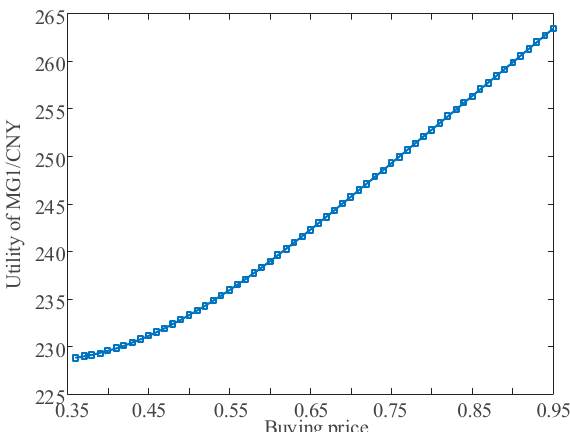
14 = 46.1, l 14 f = 141.6, = 130.7, pv 14 1 Figure A1. The utility of MG1 response to internal buying prices. ( k 1 1 1